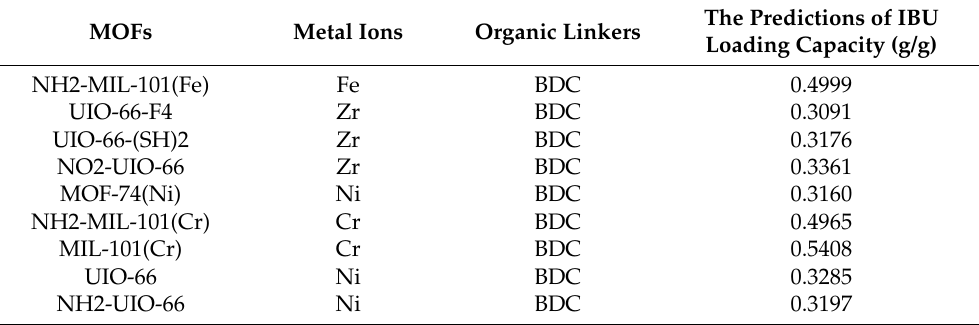
The Predictions of IBU Loading Capacity (g/g)